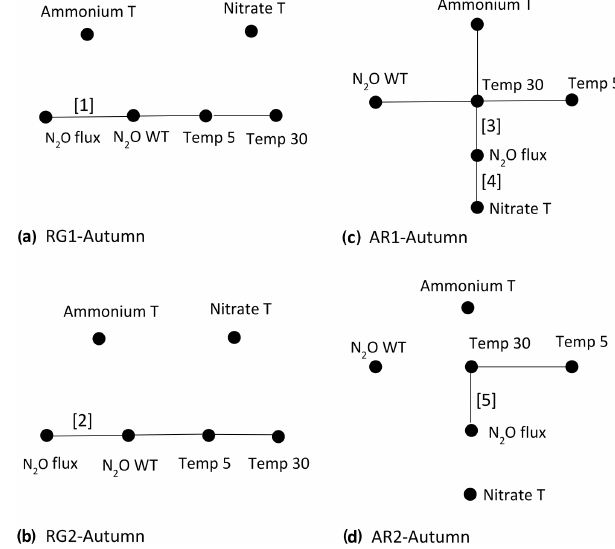
Figure 8. Results of a graphical model for each site–crop combina- tion in the autumn. (a) RG1-Autumn, (b) RG2-Autumn, (c) AR1- Autumn and (d) AR2-Autumn. The edges (lines) connecting ver- tices (points) indicate significant conditional correlation